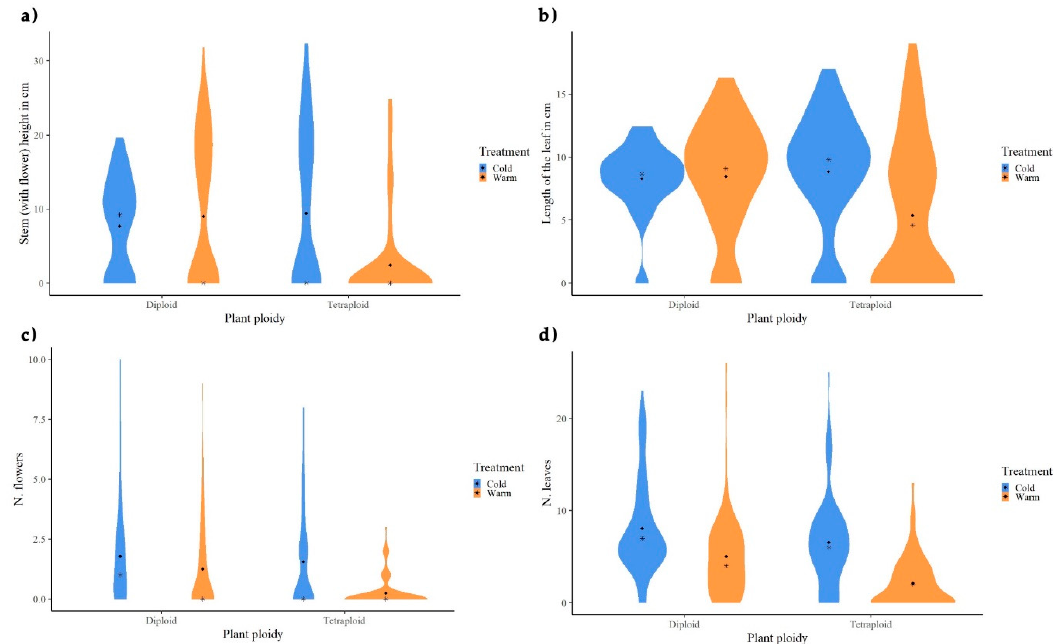
Figure 1. Violin plots of morphological traits of diploid and tetraploid Ranunculus kuepferi individuals under cold (blue) and warm (orange) temperature treatments: ( a ) stem height (with flower) in cm, ( b ) length of the longest leaf per plant in cm, ( c ) total number of flowers per plant, and ( d ) total number of leaves per plant.